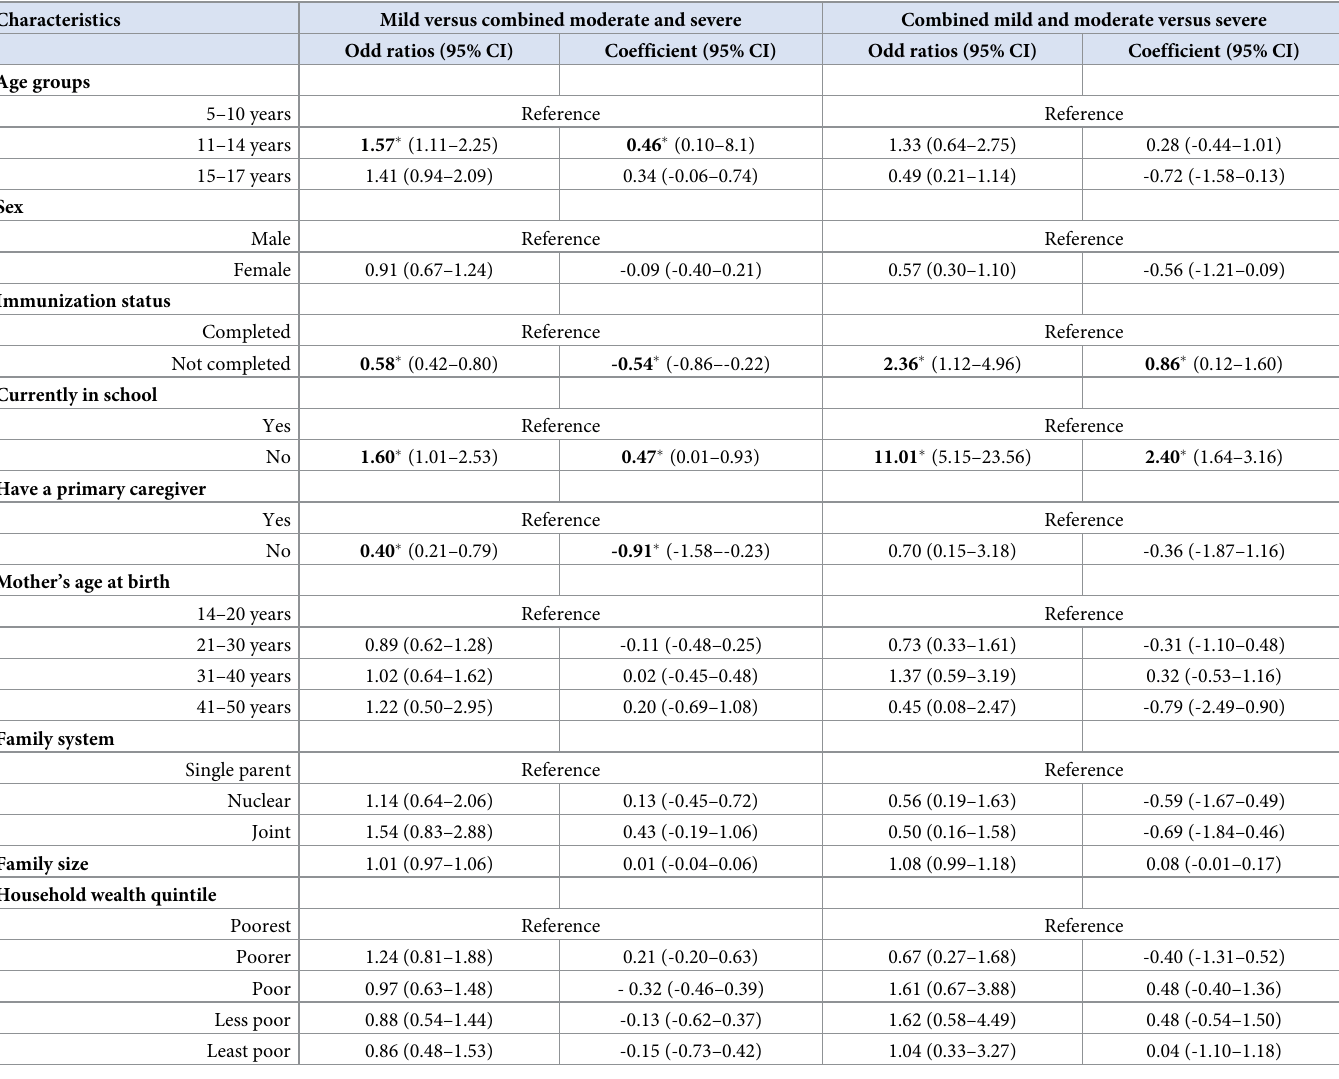
Table 5. Factors associated with disability in children living at the IM-HDSS, Uganda (Generalized ordered logistic model).